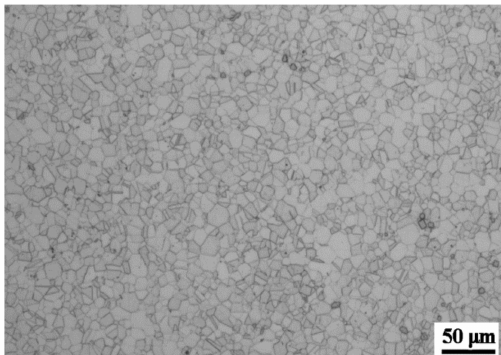
Figure 1. Grain structure of alloy 3 after direct aging heat treatment.